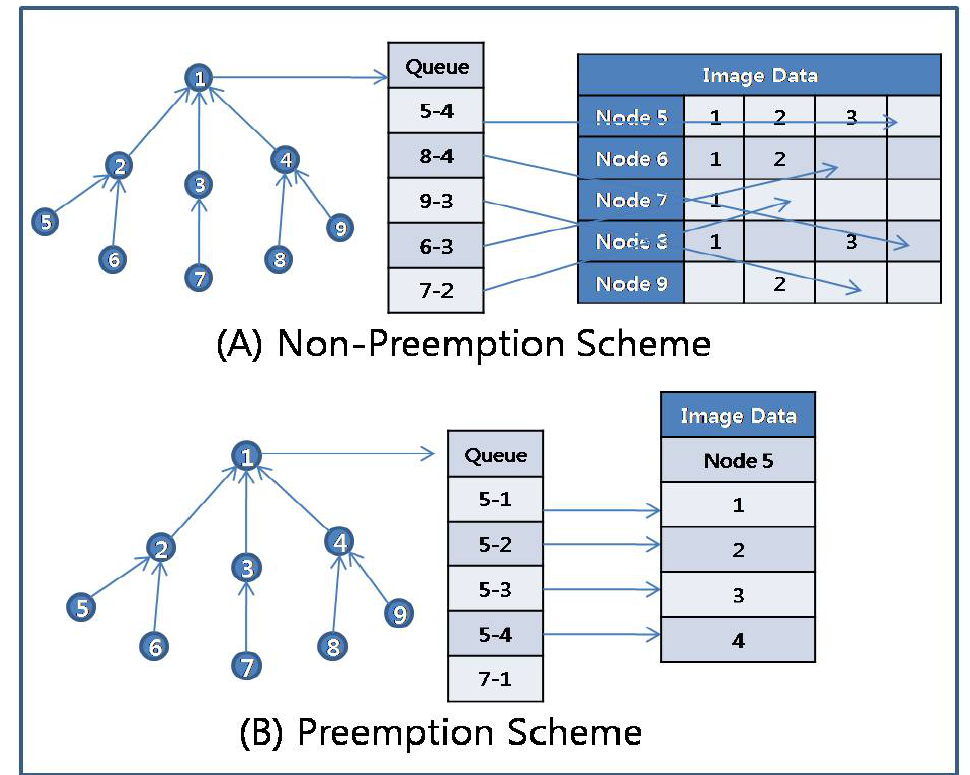
Figure 8. Management of received image packets in sink node. With non-preemption scheme (A), sink node has to manage the memory space in proportion to the number of nodes, whereas with preemption scheme (B), sink node has to manage the memory space with size of